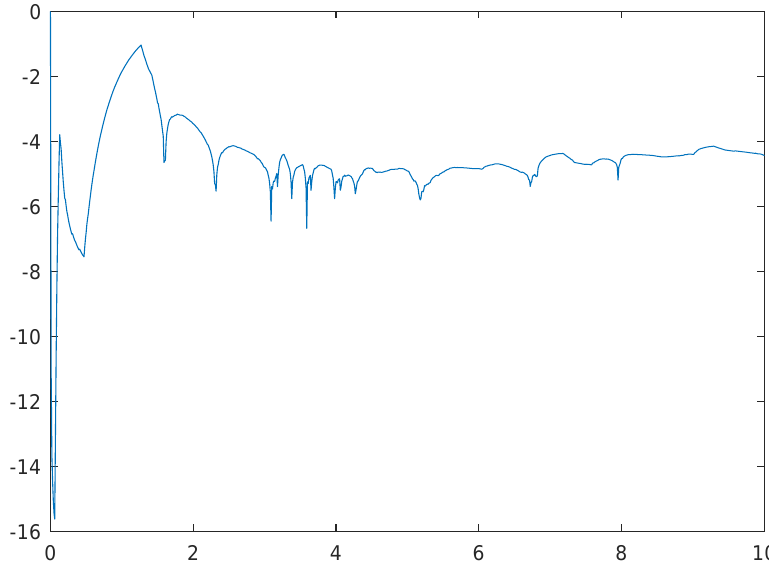
Figure 2. Computer simulation of the ln | x ( t ) | / t of the solution x ( t ) of Equation